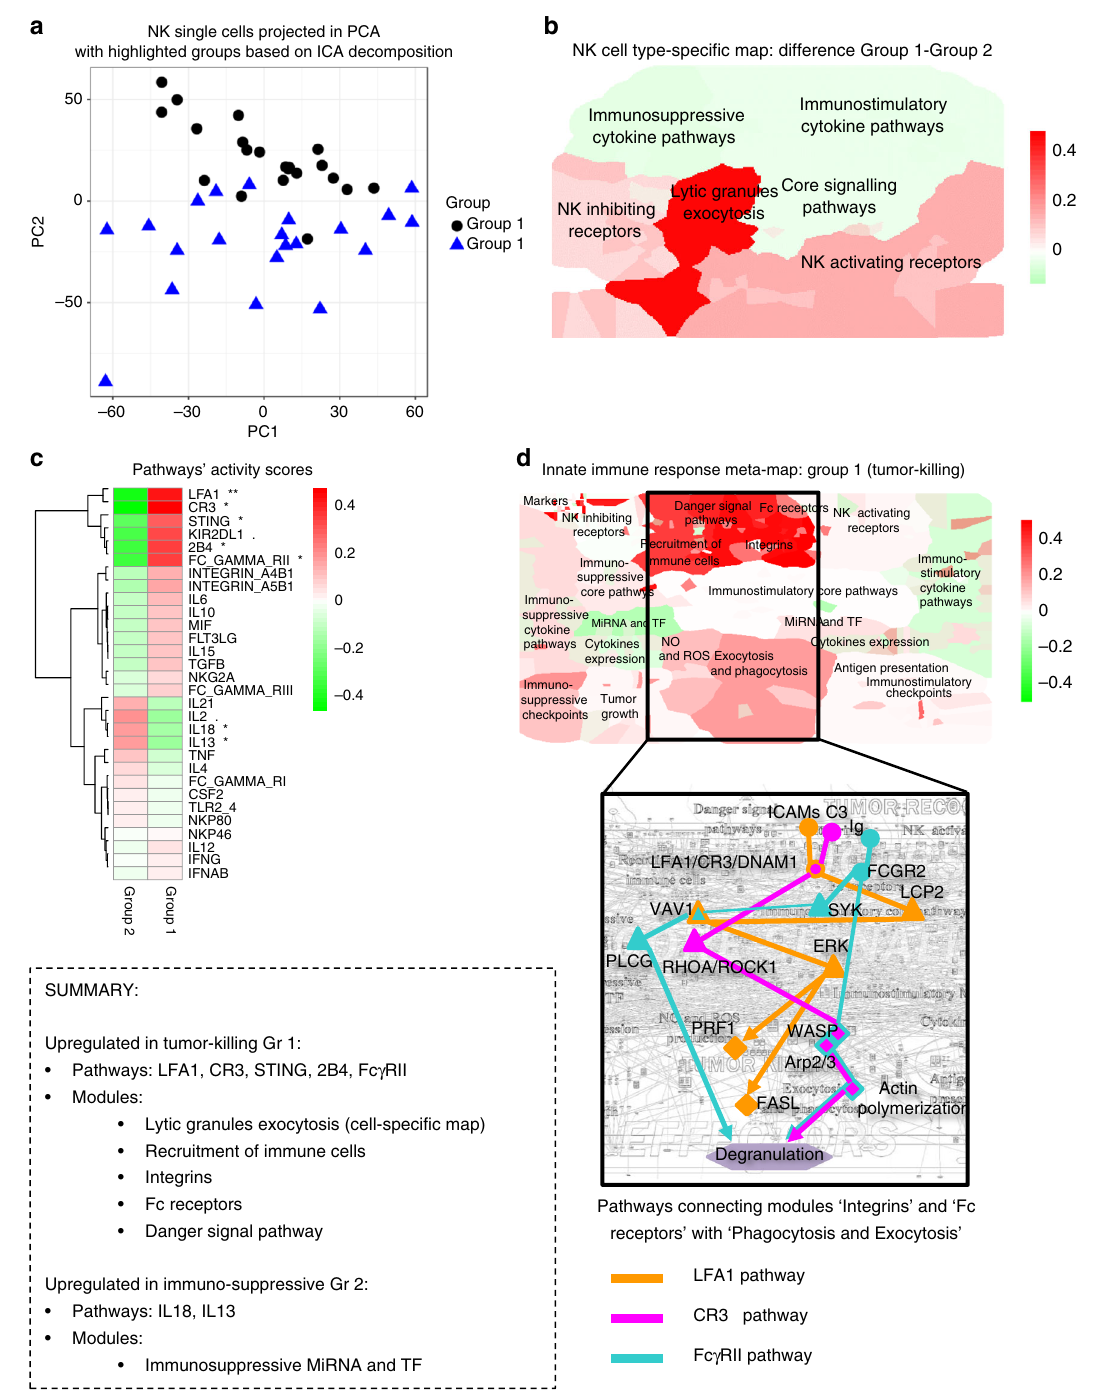
Fig. 5 Visualization of modules activity scores using expression data from melanoma natural killers (NK). NK single cells in PC1 and PC2 coordinates space. Two groups are colored distinctly in blue and black. a Map staining of the NK cell-type-speci fi c map with modules activity scores calculated from single-cell RNAseq expression data for b NK Group 1. c Heatmap of activity scores in signaling pathways of NK groups. Map staining of the innate immune response meta-map with modules activity scores for d NK Group 1 ( “ tumor killing ” ) with a zoom into three signaling pathways relating the two upregulated modules: “ Danger signal pathways ” and “ Exocytosis and phagocytosis ” with main molecular players named. Color code: red – upregulated, green — downregulated module activity. The p values of the t test were reported in the heatmaps with the standard code of signi fi cance (*** p < 0.001, ** p < 0.01, * p < 0.05, < The single-cell RNA-Seq data for macrophages and NK cells from highest variability axes as PCA, extract independent and non- metastatic melanoma samples were used 45 . Gaussian signals called components. The most stable component A matrix factorization technique, independent components was used as a way to order the cells based on some latent process analysis (ICA) 46 allows ranking genes or samples along data- that we aim to interpret using innate immune maps. In order to driven axes. The independent components instead of detecting better understand the differences in the cell ranking, the cells with